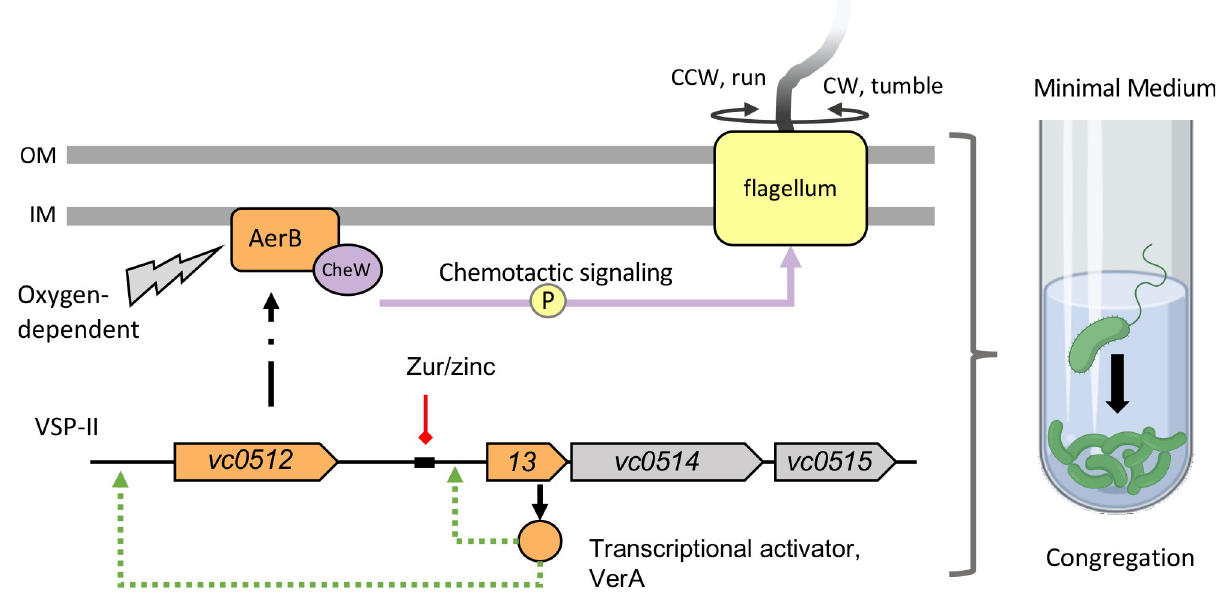
Fig 7. Proposed model of Zur-regulation of VSP-II encoded genes and its effect on chemotaxis. Zur forms a complex with divalent zinc ions and binds with high affinity to specific DNA sequences (black rectangle), repressing transcription of downstream genes (red line). In the absence of zur or during zinc starvation, VSP-II genes, including the vc0513-vc0515 operon are derepressed. The vc0513-encoded transcriptional activator VerA induces transcription (green arrow) of aerB , which encodes a chemotaxis receptor. AerB interacts with the chemotaxis coupling protein CheW (purple) and mediates a signal relay that alters flagellar (yellow) rotation and cell reorientation. AerB induction in minimal medium causes V . cholerae to congregate in an oxygen-dependent manner away from the air-liquid interface. Model created with BioRender.com.